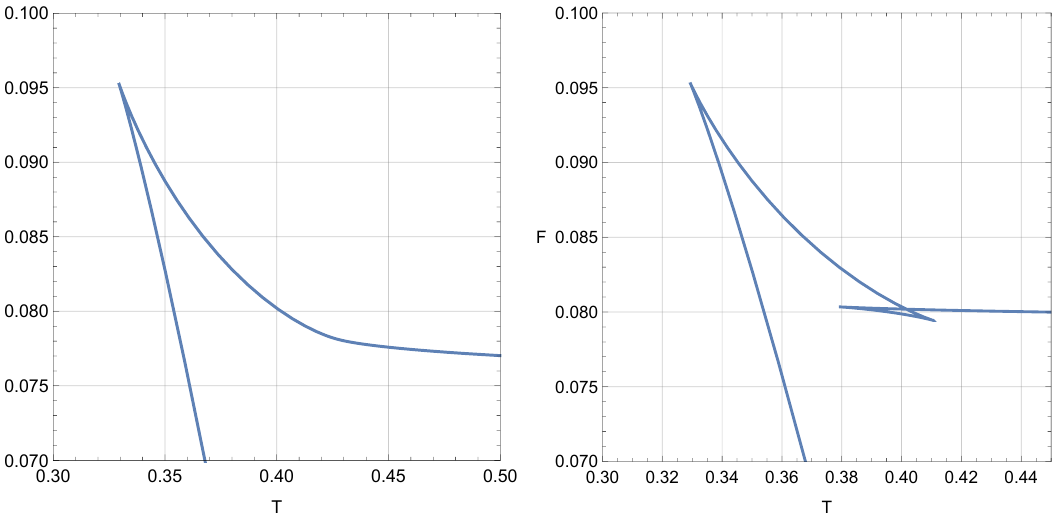
Figure 5 . Helmholtz free energy of the Born-Infeld-de Sitter black hole for (cid:12)xed cavity size ( r c = 0 : 6), pressure ( P = (cid:0) 0 : 0025), and charge ( q = 0 : 1). Left : b = 4. Right : b = 4 :